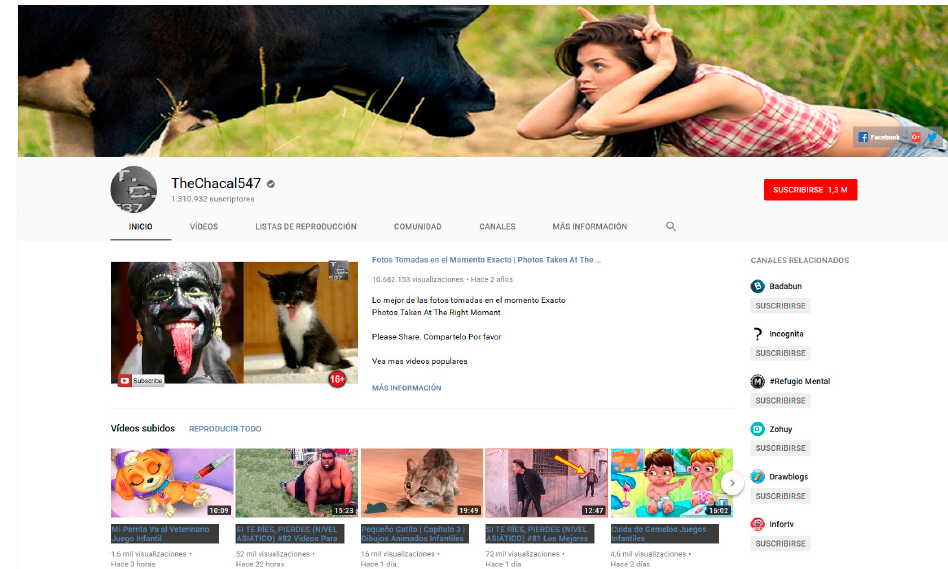
Figure 3. Front page of the YouTube channel, TheChacal547.